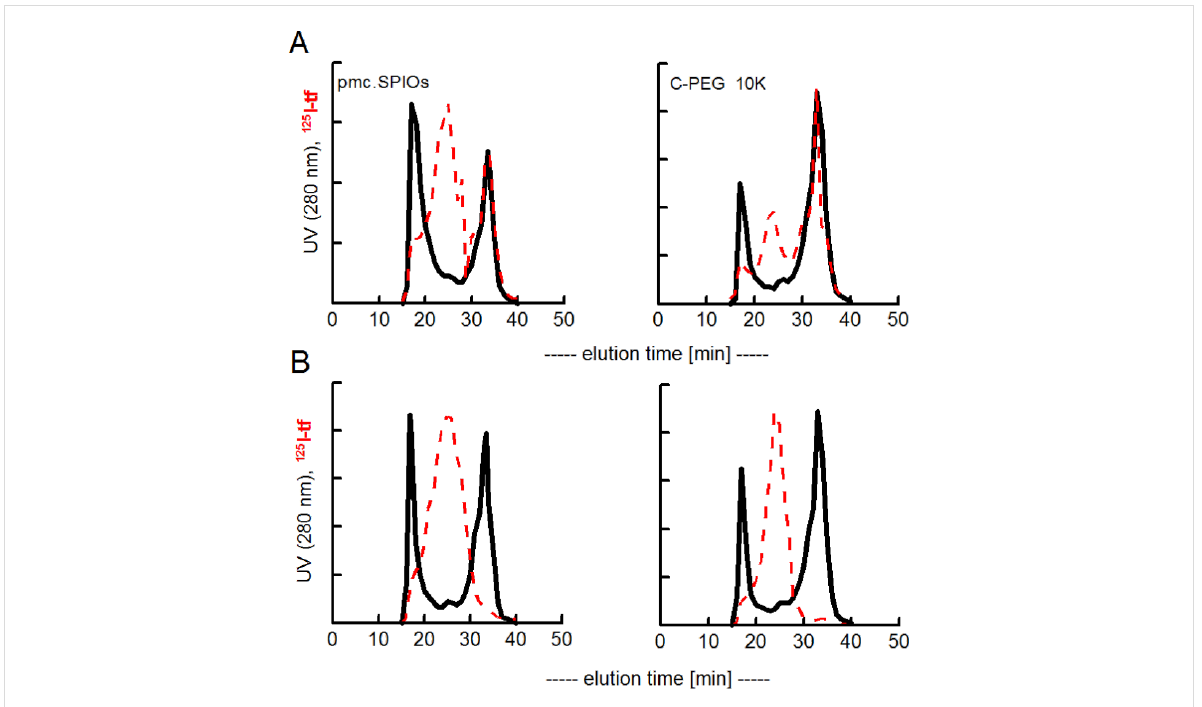
Figure 3: FPLC analysis of remaining transferrin after exchange with additionally added whole plasma (3 fold excess to initial transferrin). Same experiment as described in Figure 2. A, initial transferrin adsorbed; B, initial transferrin covalently bound. The peak at 33 min represents proteins with the size of transferrin (DLS: 9 nm).